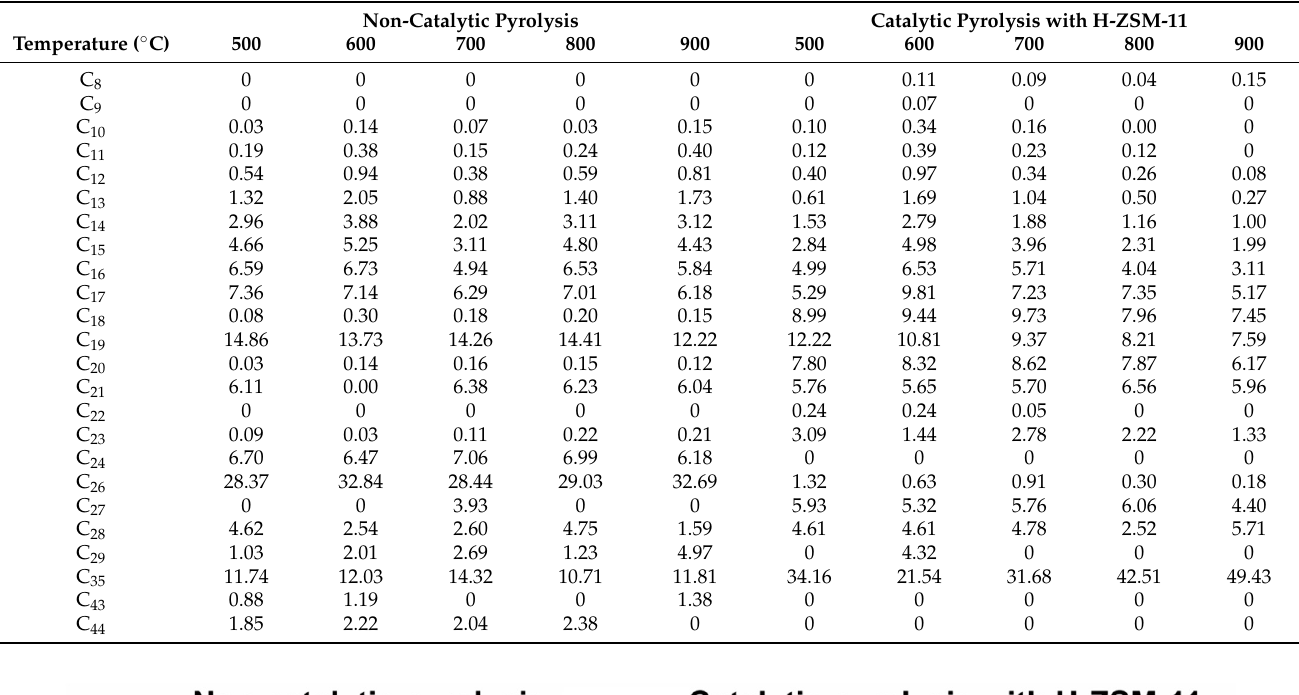
Table 2. Yields (%) of hydrocarbons with different carbon numbers in the pyrolytic liquid produced via the pyrolysis of LDPE without and with the H-ZSM-11 catalyst as functions of pyrolysis temperature.